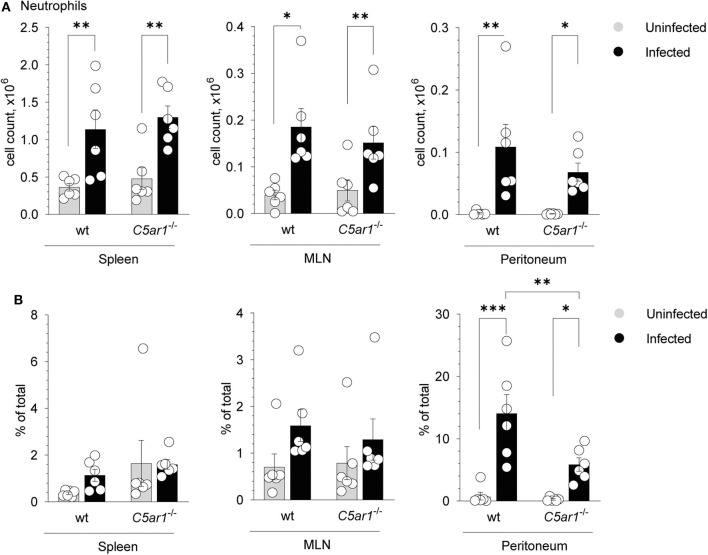
Impact of C5aR1 activation on neutrophil recruitment into the spleen, mesenteric lymph nodes and the peritoneum. (A,B) Number (A) or frequency (B) of neutrophils in the spleen (left panel), mesenteric lymph nodes (MNL; middle panel) and peritoneum (right panel) of uninfected and T. gondii-infected wt and C5ar1−/− mice. Values shown are the mean ± SEM; n = 6/group. Differences between groups were determined by ANOVA and Sidak's post-hoc test, *p < 0.05, **p < 0.01, ***p < 0.001.